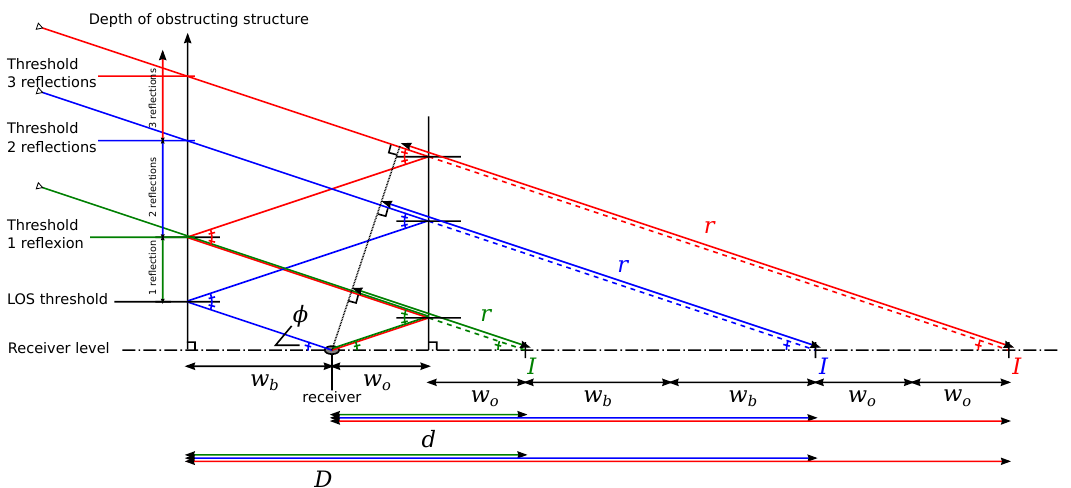
Figure 16. Reflected GNSS rays trajectories following the cross-section in the plane defined by the ray and receiver.